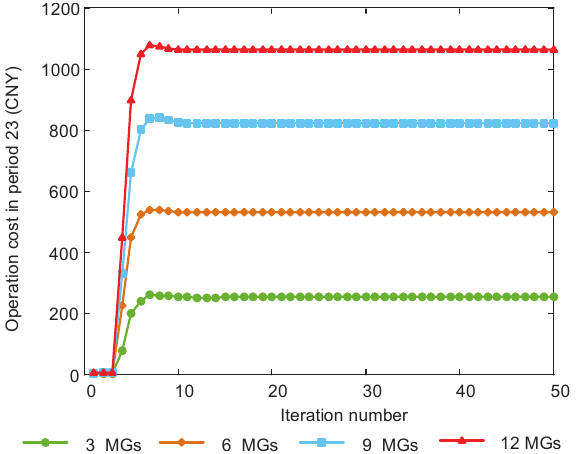
Figure 27. The iterative process of the operation cost in Period 23 for coalitions with different numbers of MGs. Table 9. The comparison of the total operation cost and average iteration number between coalitions with different numbers of